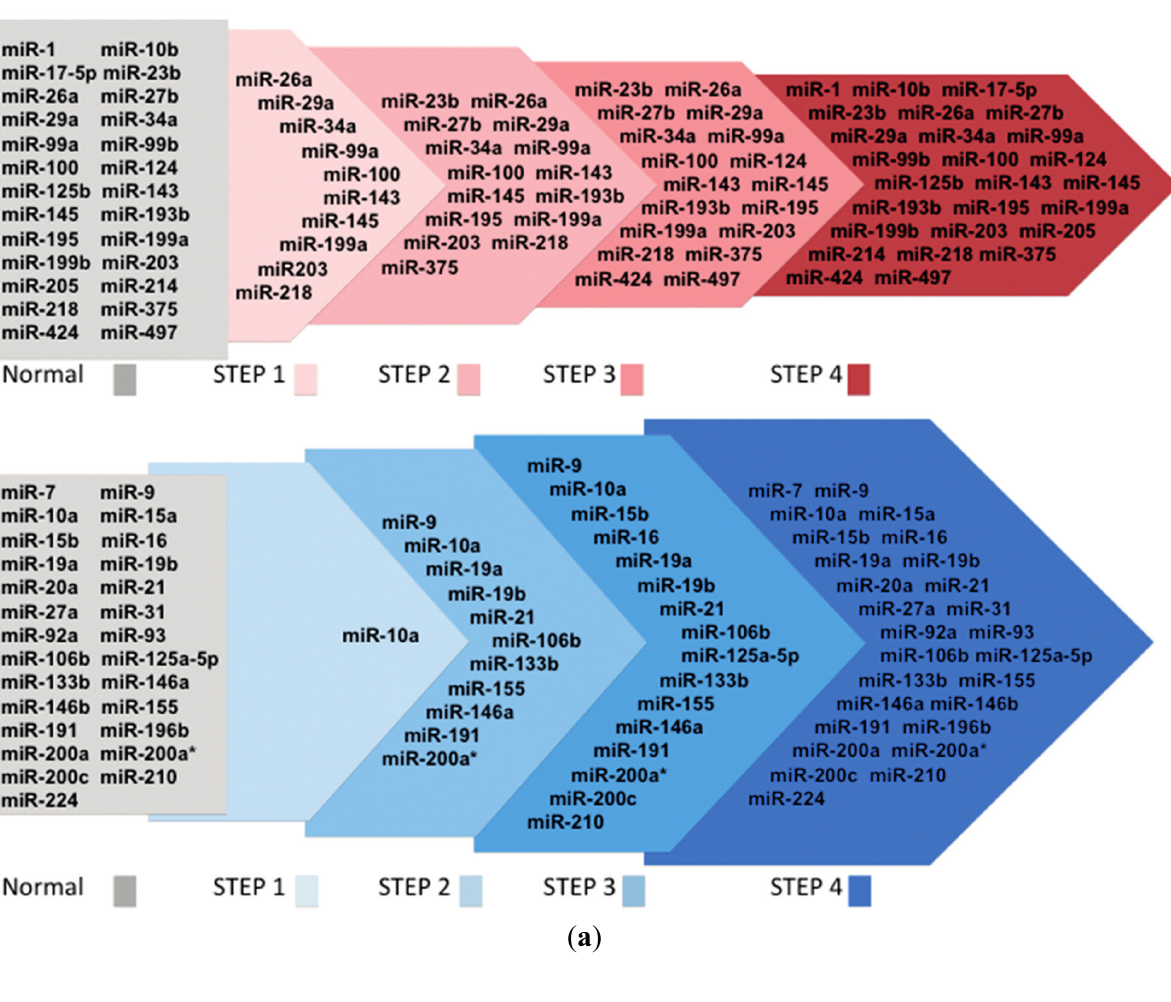
Figure 1. ( a ) MicroRNAs (miRNAs) implicated in cervical cancer progression. miRNAs are accommodated in steps 1, 2, 3 and 4 according to their expression. In the upper scheme, the arrow represents progressive miRNAs reduction. In the bottom scheme, the arrow represents progressive miRNAs increase; ( b ) miRNAs and their target coding genes implicated in cervical cancer progression. In the neoplasic stage, step 1, one oncomiR